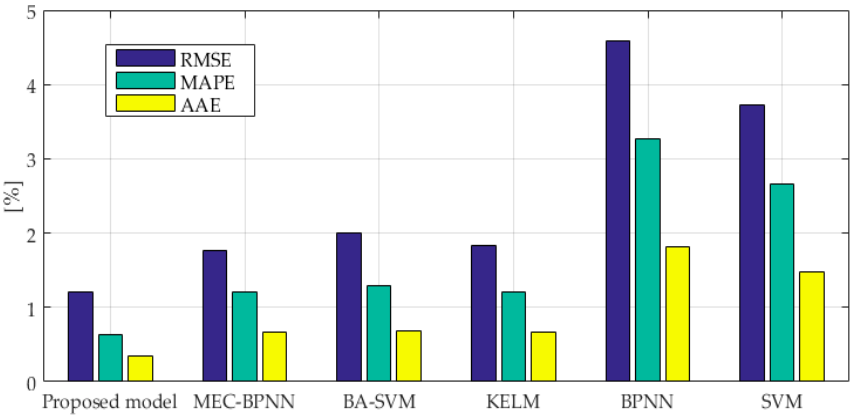
Figure 10. Values of root-mean-square error (RMSE), mean absolute percentage error (MAPE) and average absolute error (AAE).